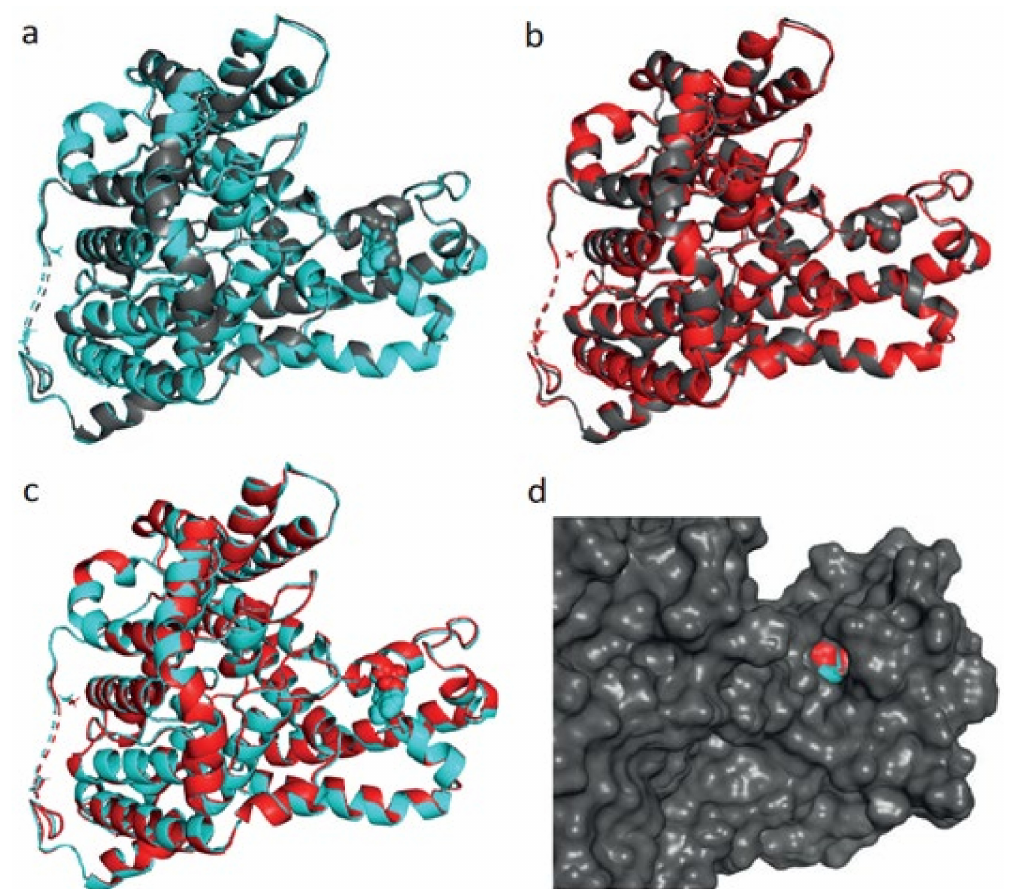
Figure 6. ( a ) Aligned structure of solute carrier family 4, sodium borate transporter, member 11 protein wildtype (918 aa, grey colour) and energy-minimised wildtype (cyan colour). ( b ) Aligned structure of SLC4A11 protein mutant (grey colour) and energy-minimised mutant (red colour). ( c ) Aligned structure of energy-minimised solute carrier family 4, sodium borate transporter, member 11 protein wildtype (cyan) and energy-minimised mutant (red). ( d ) Surface view of aligned structure of energy-minimised solute carrier family 4, sodium borate transporter, member 11 protein wildtype (cyan) and energy-minimised mutant